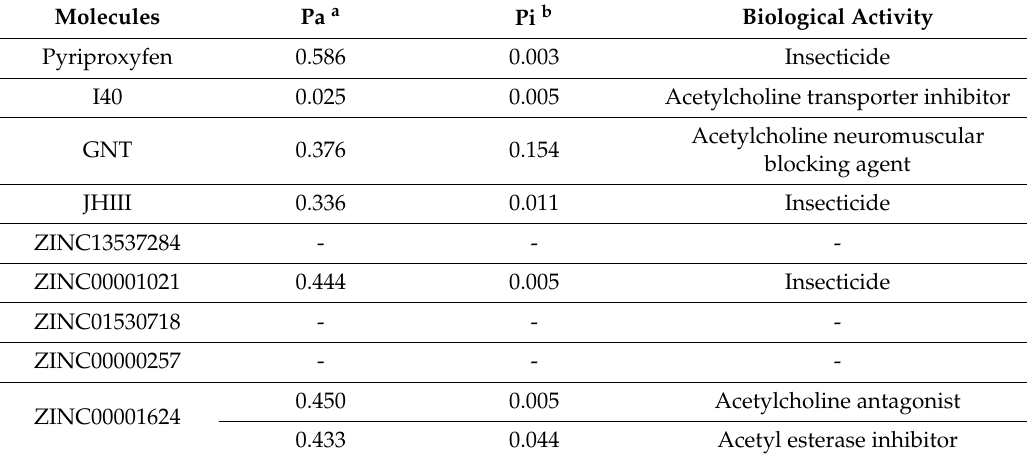
Figure 2. 2D structures of selected molecules with good pharmacokinetic and toxicological profiles. Table 3. Biological activity prediction of the compounds selected by virtual screening.